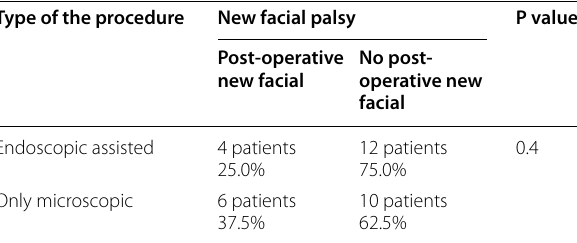
Table 1 Intraoperative detection of residual after introduction of the endoscope